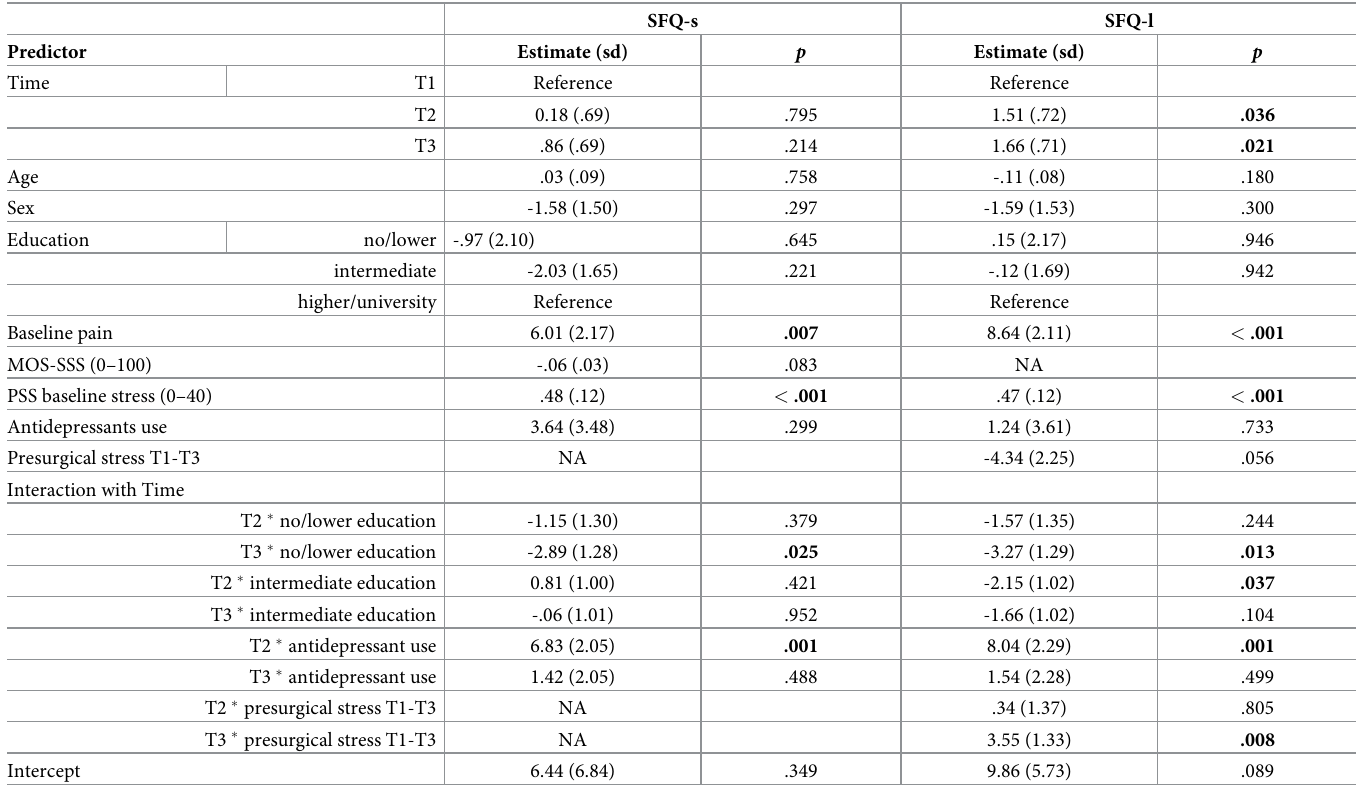
Table 3. Predictors of surgical